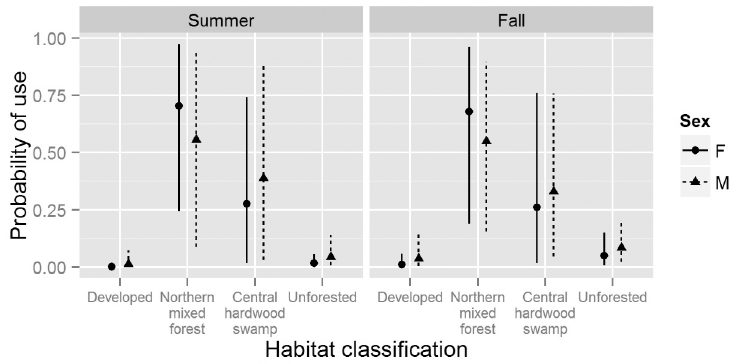
Fig 2. Predicted probability of selecting a roost as a function of habitat classification for male and female Indiana bats ( Myotis sodalis ) in summer and fall months in Fort Drum, NY, USA between 2007 – 2011. Points indicate mean posterior probability of use and vertical lines represent the limits of 95% credible intervals. This Fig assumes bats are faced with a choice of 4 potential roosts, one in each habitat classification. All other variables are assumed constant across habitat classifications.